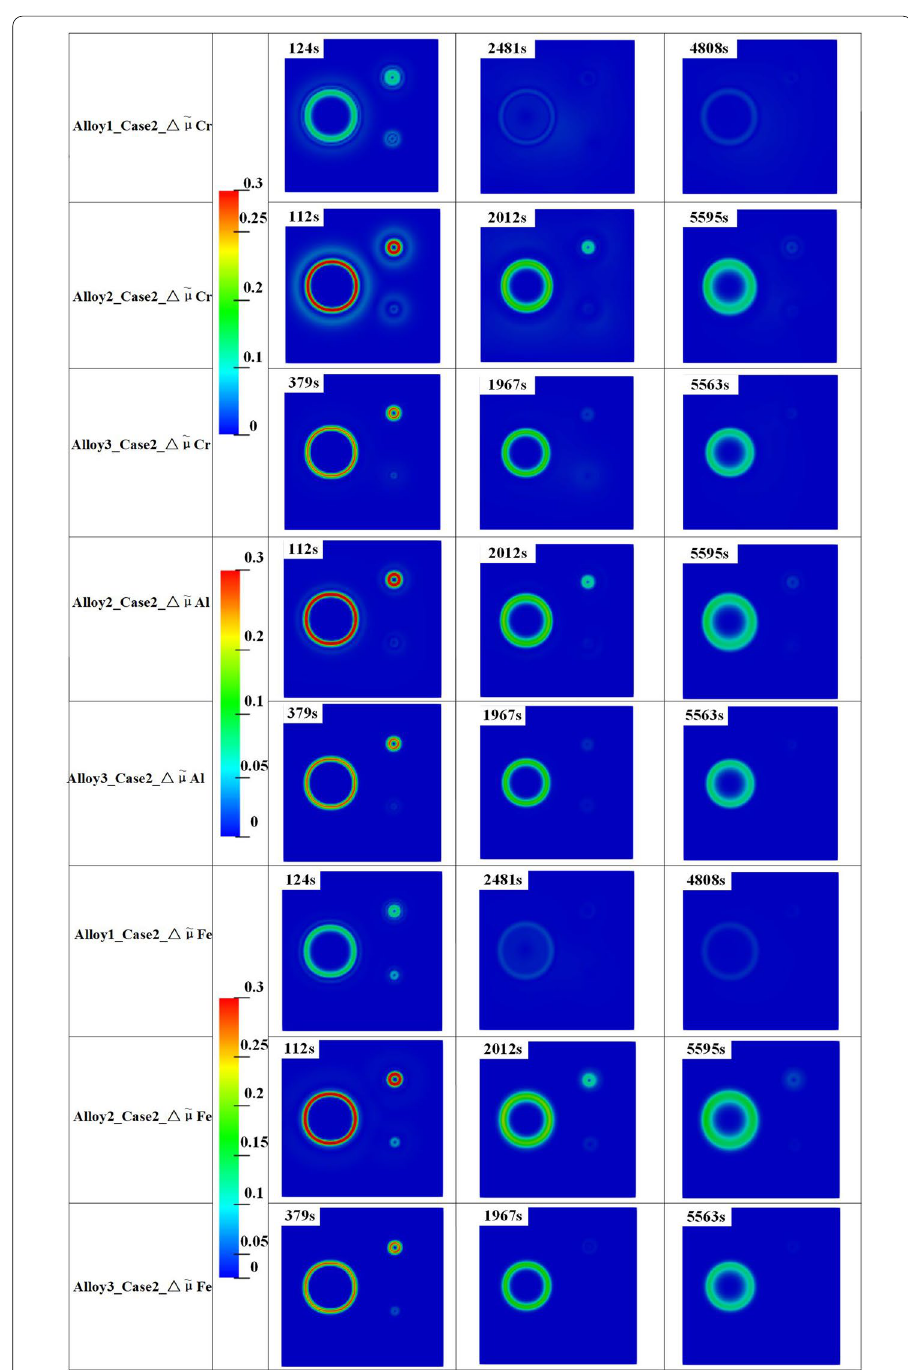
Fig. 9 Gradient of the diffusion potentials for (Al)CrFeNi